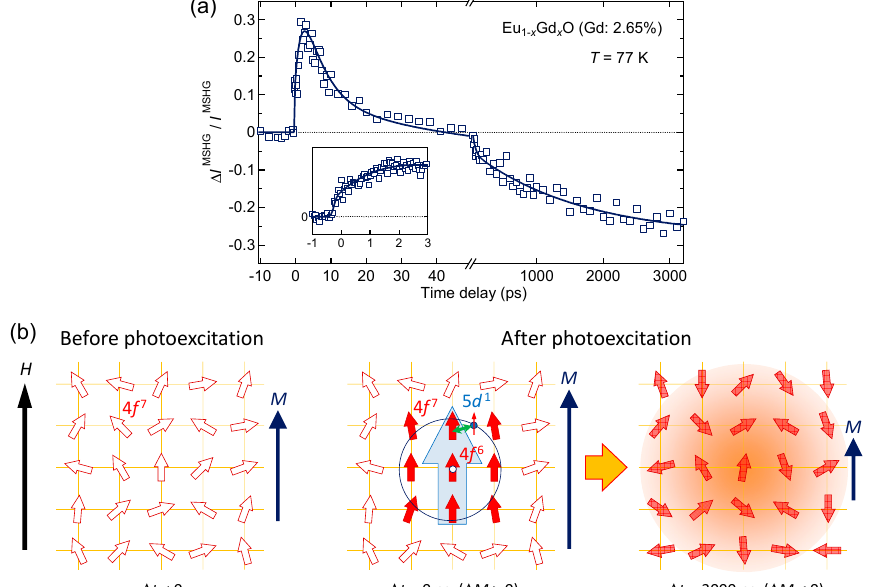
Figure 5. ( a ) Time evolution of the photoinduced change of the MSHG intensity normalized by the value before optical excitation, ∆ I MSHG / I MSHG at 77 K for EuO doped with 2.65% Gd. The excitation density of the pump pulse is ∼ 380 µ J/cm 2 . The inset shows a magnified view of the ultrafast increase of the MSHG signal. Solid lines are guides to the eyes. ( b ) Schematics of ultrafast alignment of localized 4 f 7 spins by resonant 4 f –5 d photoexcitation and subsequent demagnetization processes.